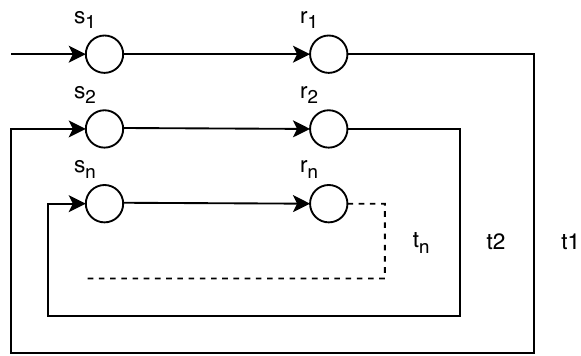
Figure 3. Behavior and perception